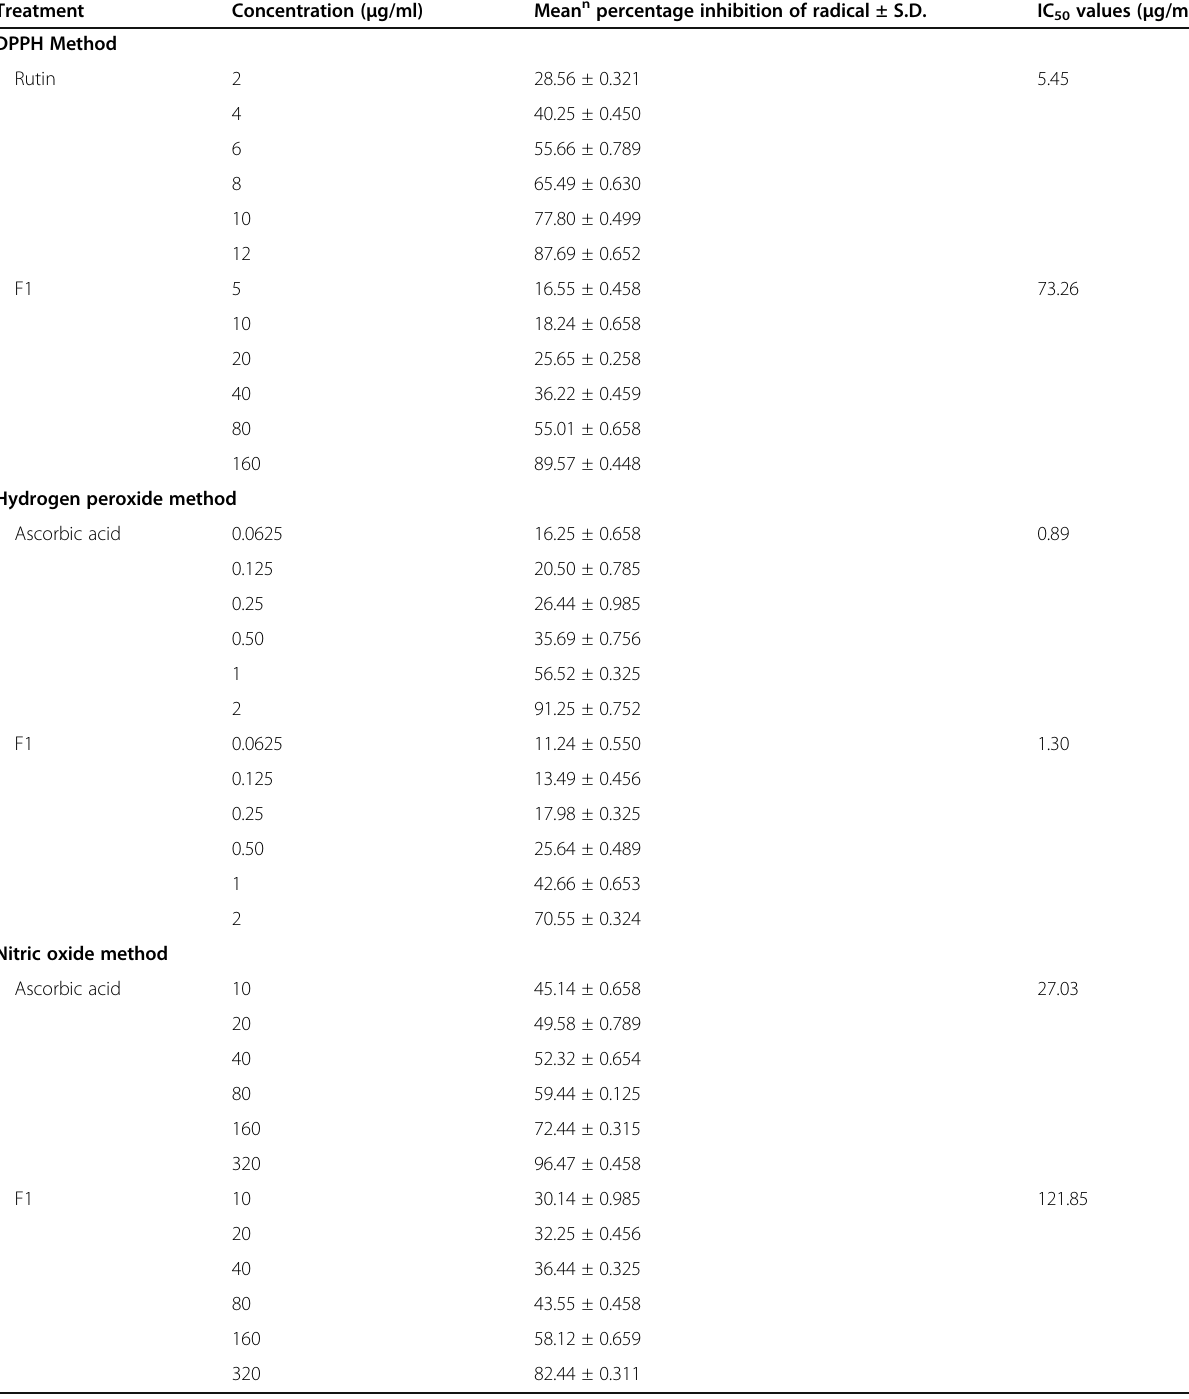
Table 3 Table showing data of antioxidant activity by various methods Treatment Concentration ( μ g/ml) Mean n percentage inhibition of radical ±